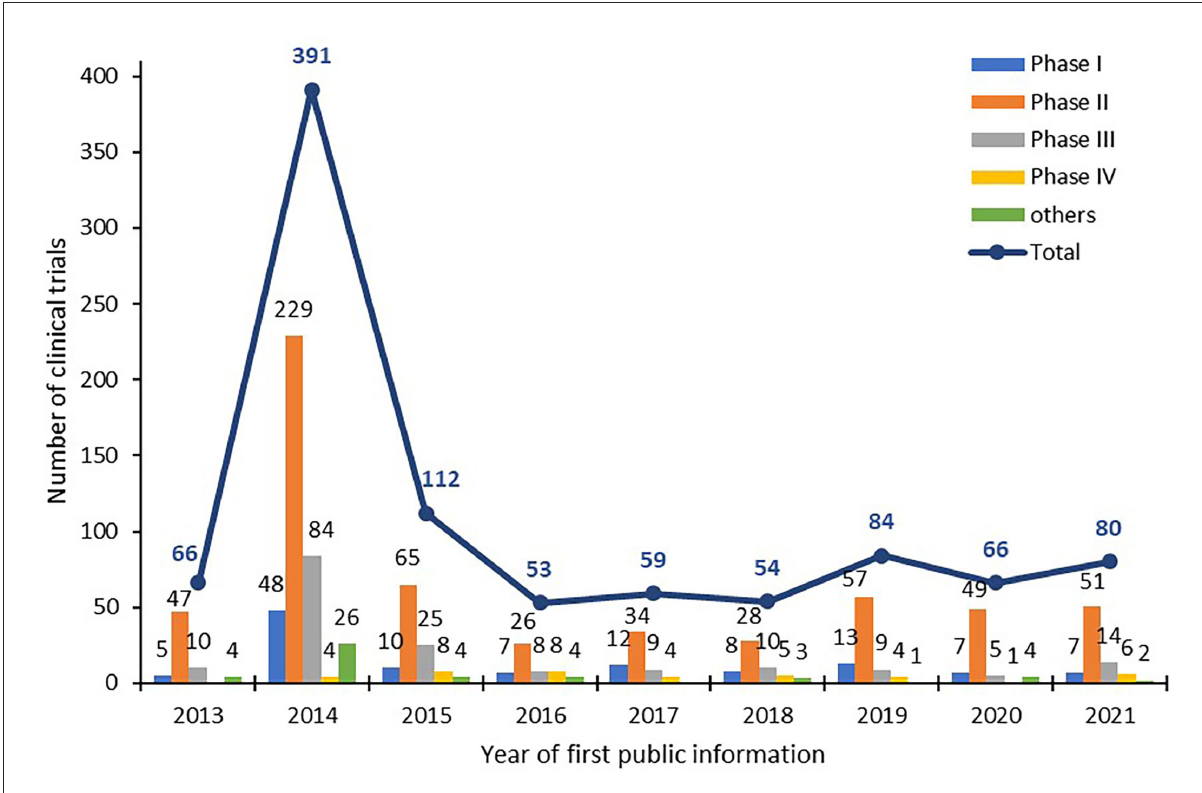
FIGURE1 Number of trials of new TCMs registered in mainland